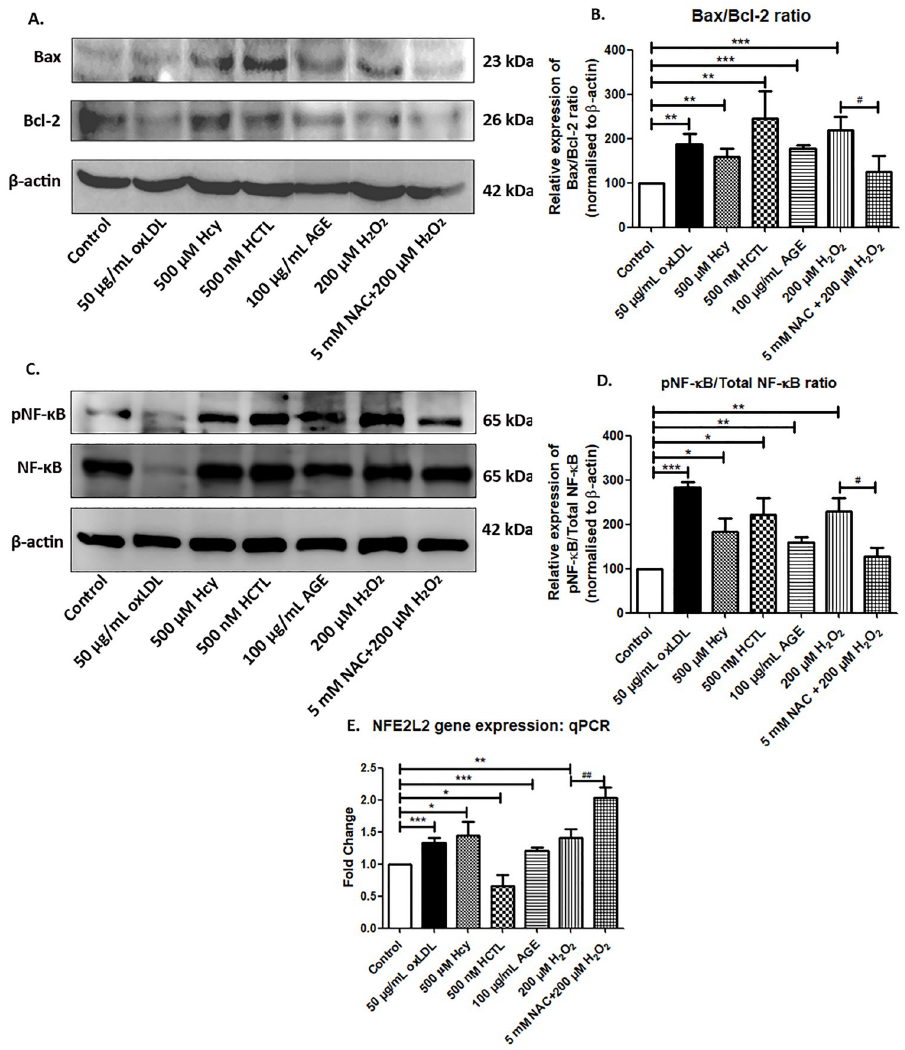
Fig 4. Pro-apoptotic changes in ARPE-19 cells. (A) Bax and Bcl-2 protein expression in ARPE-19 under the pro- oxidants conditions treated for 24 h was assessed by western blot. (B) Densitogram analysis of Bax/Bcl-2 ratio normalized to control. (C) pNF- κ B and NF- κ B protein expression in ARPE-19 under the pro-oxidants conditions treated for 24 h was assessed by western blot. (D) Densitogram analysis of pNF- κ B/NF- κ B ratio normalized to control. (E) NFE2L2 gene expression was quantified by qPCR in ARPE-19 cells exposed to pro-oxidant conditions for 24 h. Values are expressed as Mean ± SEM, n = 3. � ; # p < 0 . 05 , �� , ## p < 0 . 01 , ��� p < 0 . 001 , considered as significant. � Control vs pro-oxidants, # H 2 O 2 vs